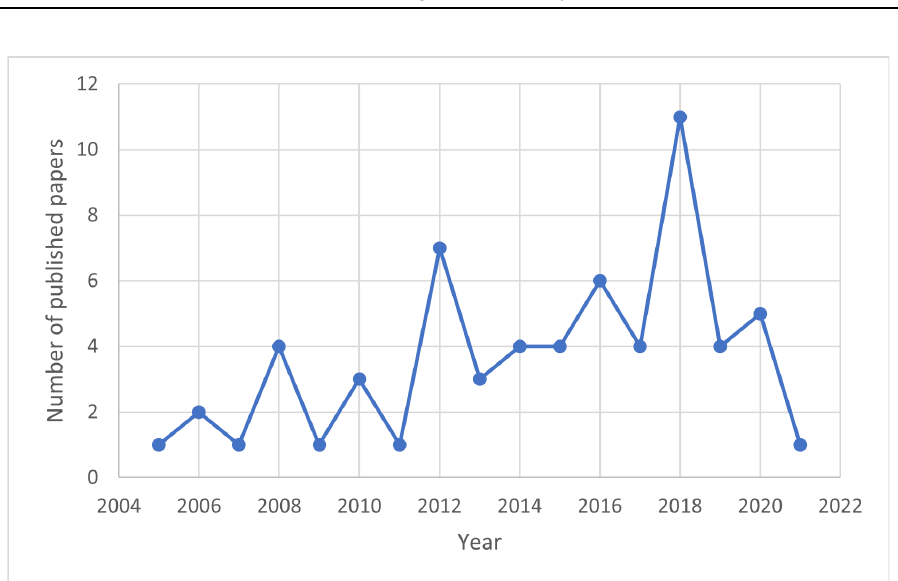
Figure 2. Number of published documents by